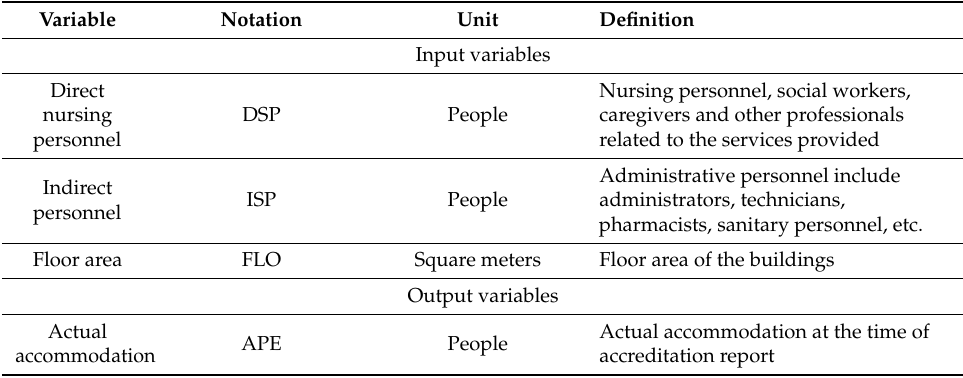
Table 1. Variable